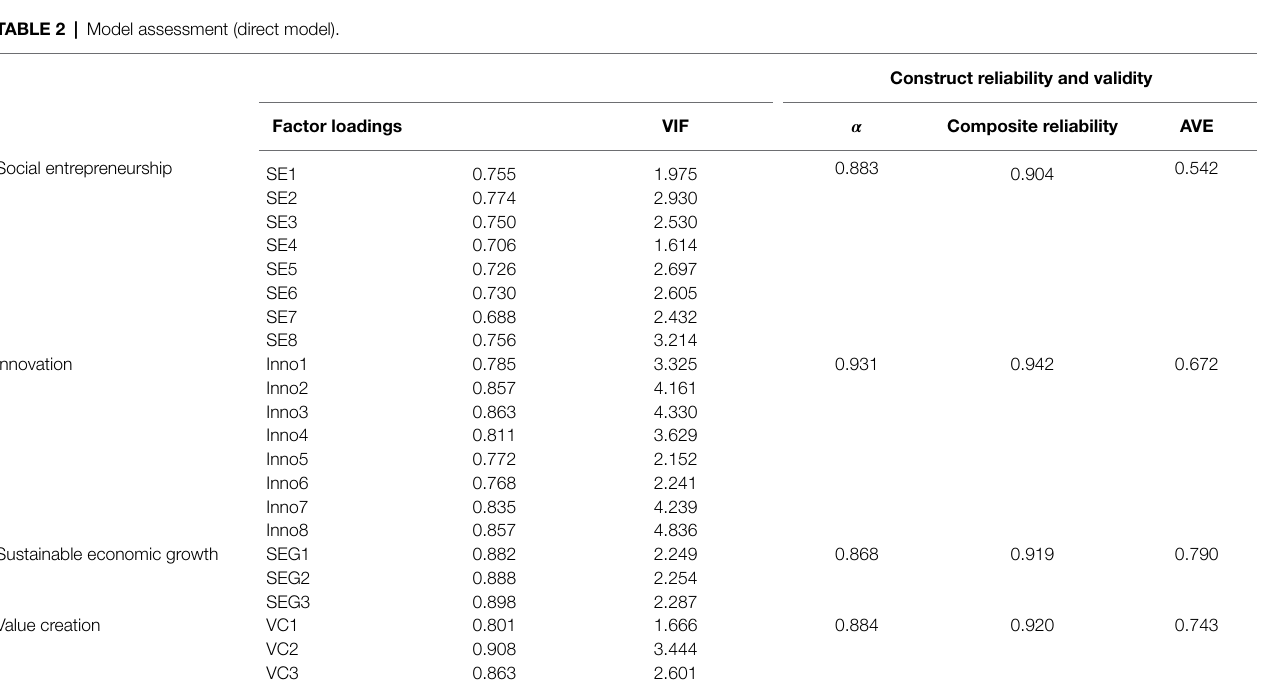
TABLE 2 | Model assessment (direct